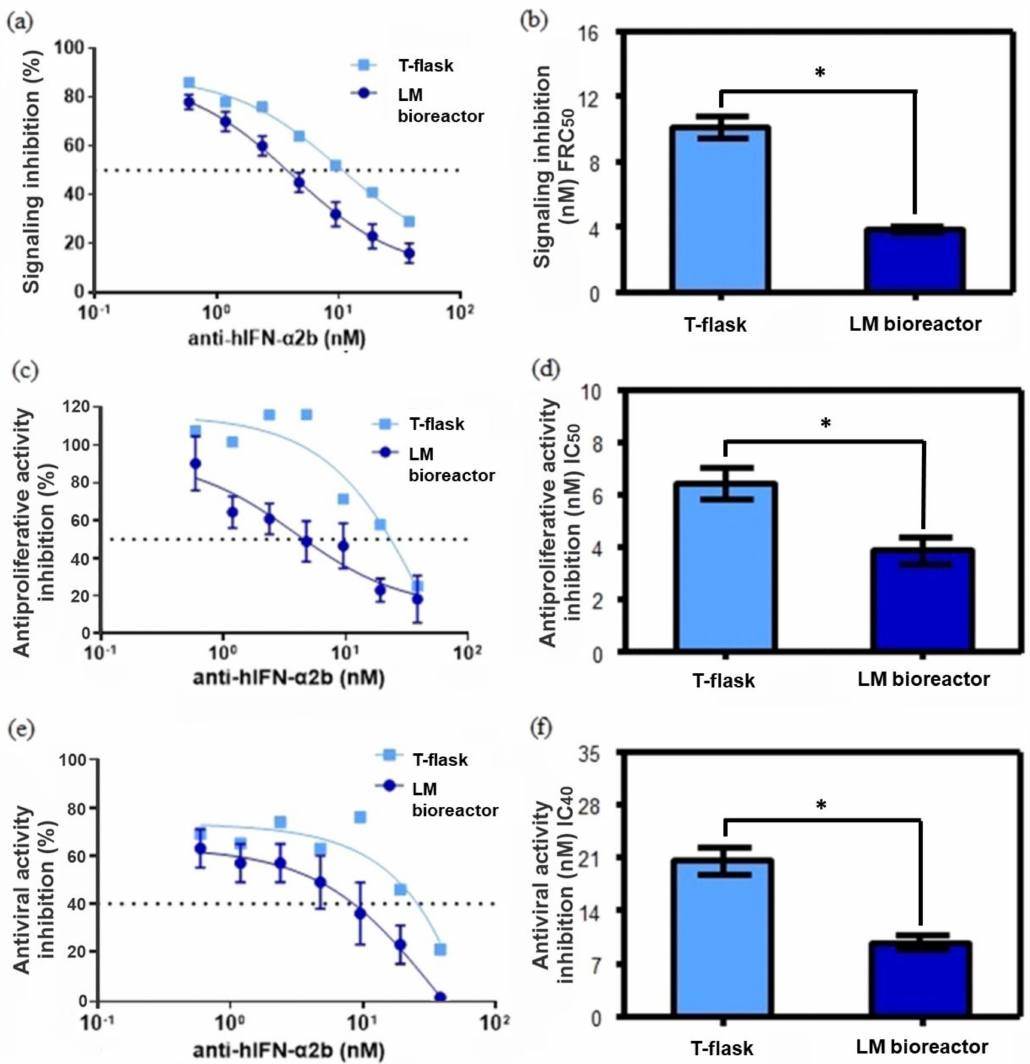
Figure 7. Evaluation of the neutralizing capacity of the biological activity of the anti-hIFN- α 2b produced in LM bioreactor and T-flask. ( a ) Dose-response curve of the rhIFN- α 2b signaling inhibition with increasing concentrations of the mAb produced in the LM bioreactor and T-flask. ( b ) Inhibition was measured as the concentration of mAb necessary to reduce 50% of fluorescence (FRC 50 ) using HelaMx2/eGFP cells. ( c ) Dose-response curve of the rhIFN- α 2b antiproliferative activity inhibition with increasing concentrations of the mAb produced in LM bioreactor and T-flask. ( d ) Inhibition was measured as the concentration of mAb necessary to reduce 50% of the maximum cytokine potency (IC 50 ) using Daudi cells. € Dose-response curve of the antiviral activity inhibition of rhIFN- α 2b with increasing concentrations of the mAb produced in the LM bioreactor and T-flask. ( f ) The rhIFN- α 2b antiviral activity inhibition was measured as the concentration of mAb necessary to reduce 40% of the maximum cytokine potency (IC 40 ). The error bar represents the standard error of the mean. The presence of asterisks (*) denotes significant differences determined by Tukey’s test p < 0.05, than those calculated for the mAb produced in the T-flask, determined by ANOVA followed by Tukey’s